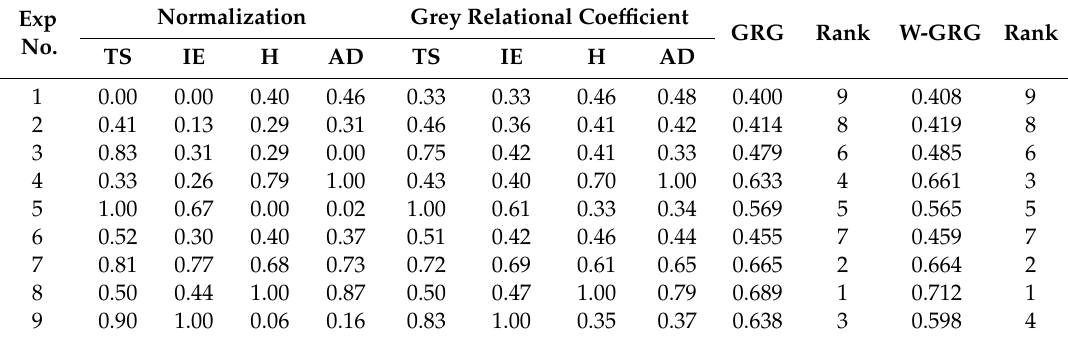
Table 7. Calculated Normalized, GRC and GRG for 9 experiments.